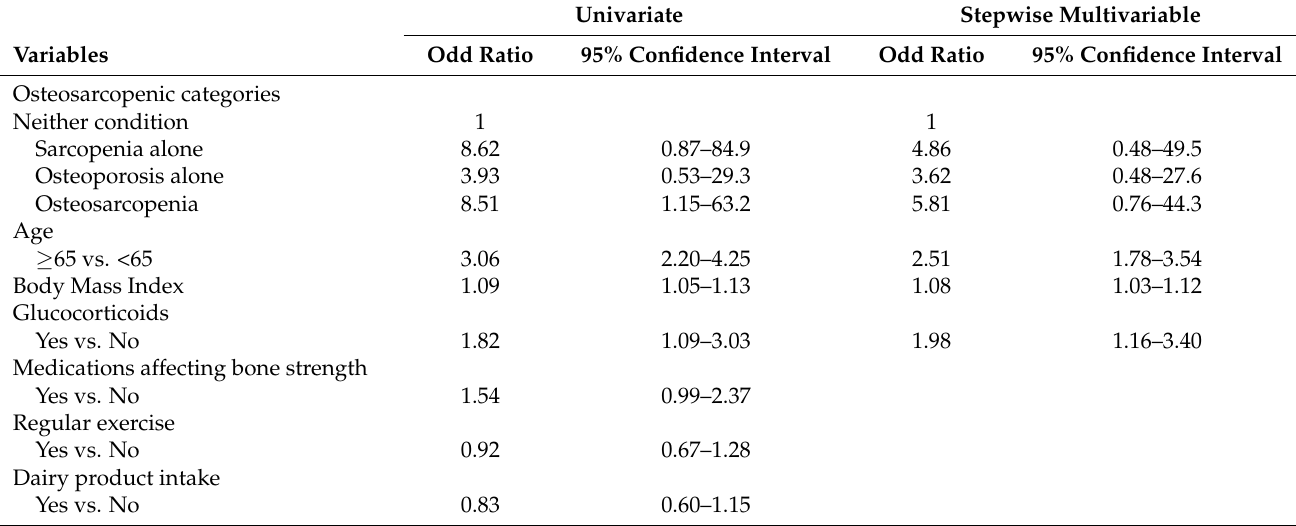
Table 3. Odds ratios for fragility fractures according to osteosarcopenic categories, in which the “osteo” component was defined T-score < − 1